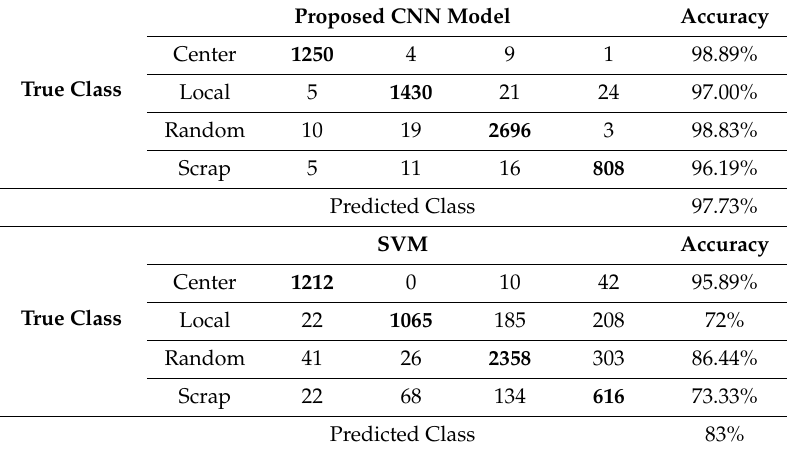
Table 1. Confusion matrices of SVM and CNN classifications.